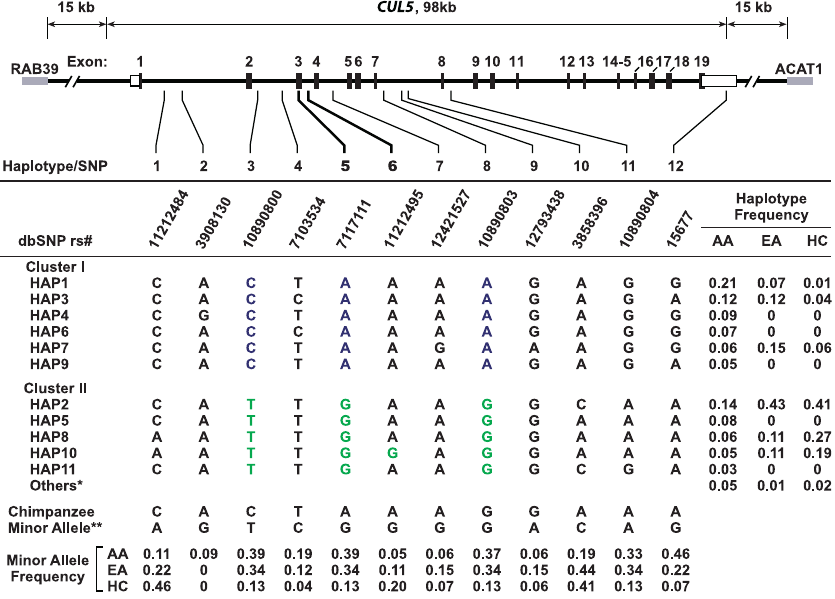
Figure 1. Gene Map, SNPs, and Haplotypes in the Human CUL5 Gene Coding exons are marked by black blocks, and 5 9 and 3 9 UTR by white blocks. Nucleotide changes and frequencies of SNPs and haplotypes (Hap) in AA, EA, and HC are presented. ctSNPs are shown in color.